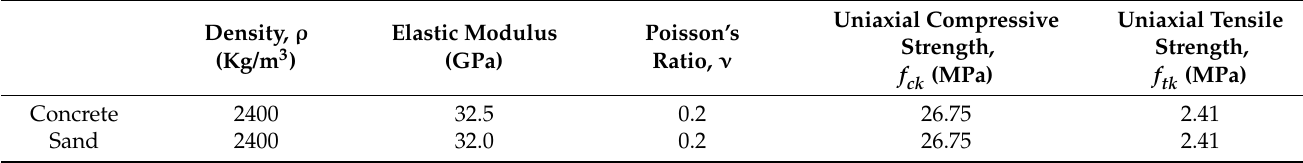
Table 3. Mechanical properties of concrete.